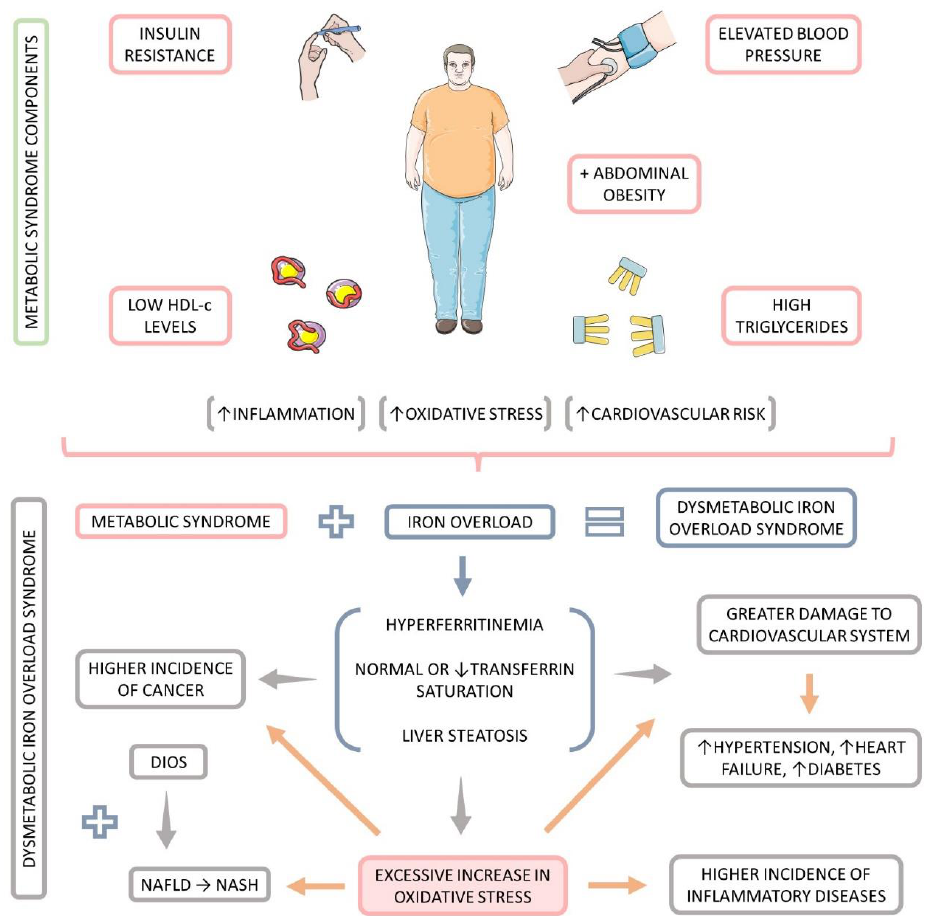
Figure 1. Definition of dysmetabolic iron overload syndrome (DIOS). ↑ : increase, ↓ : decrease.